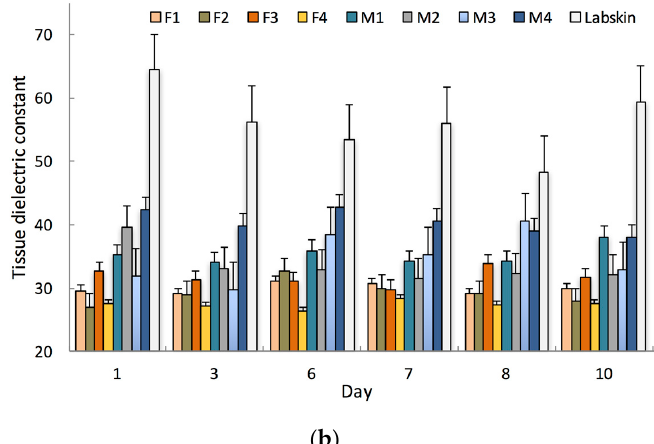
Figure 2. ( a ) Measured pH values for Labskin and human participants’ skin over a 10-day period; ( b ) Measured tissue dielectric constants (TDC) for Labskin and human participants’ skin over a 10-day period. (F = female, M = male, Error bars represent the 95% confidence interval, n = 3). The barrier electrical properties of Labskin and human skin were impedimetrically assessed using screen-printed tattoo electrodes and the impedance data is presented as Bode and Nyquist plots (Figure 3). A Nyquist plot visualises the data as a complex plane by plotting the real (Z ′ ) and imaginary (Z ″ ) with every point providing a characteristic feature at a certain frequency. In comparison, the Bode plot showcases the amplitude/magnitude and the phase over the frequency range analysed, which is an advantageous compared to the Nyquist plot where frequency is not explicitly presented.